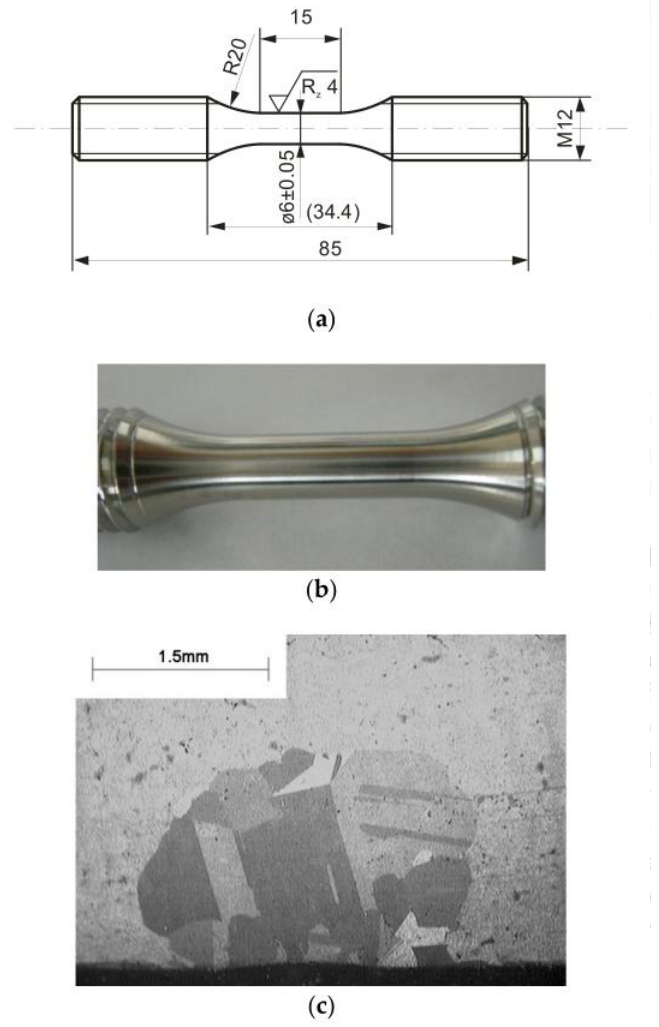
Figure 2. Single crystal fatigue test samples: ( a ) specimen dimensions; ( b ) specimens appearance; ( c ) optical microstructure of the local recrystallized grains generated by indention and